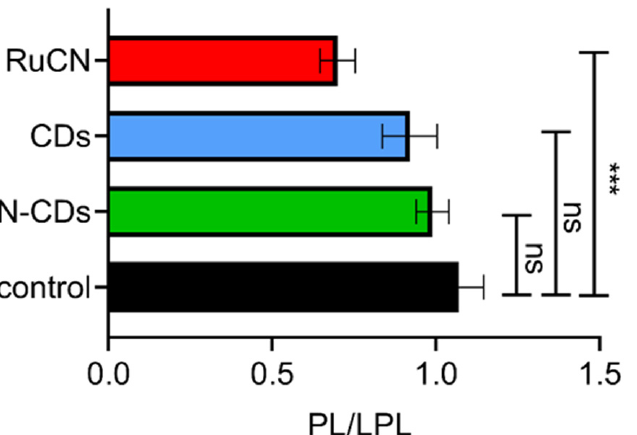
Figure 3. The ratio between SN values of PLs and LPs (PL/LPL) was obtained from MALDI TOF spectra after the treatment with Ru-CN metallodrug, N-CDs, and CDs. All the values are compared to the control (PL and LP ratio of untreated cells). ns, not significant, p > 0.05; ***, significant, p ≤ 0.001.